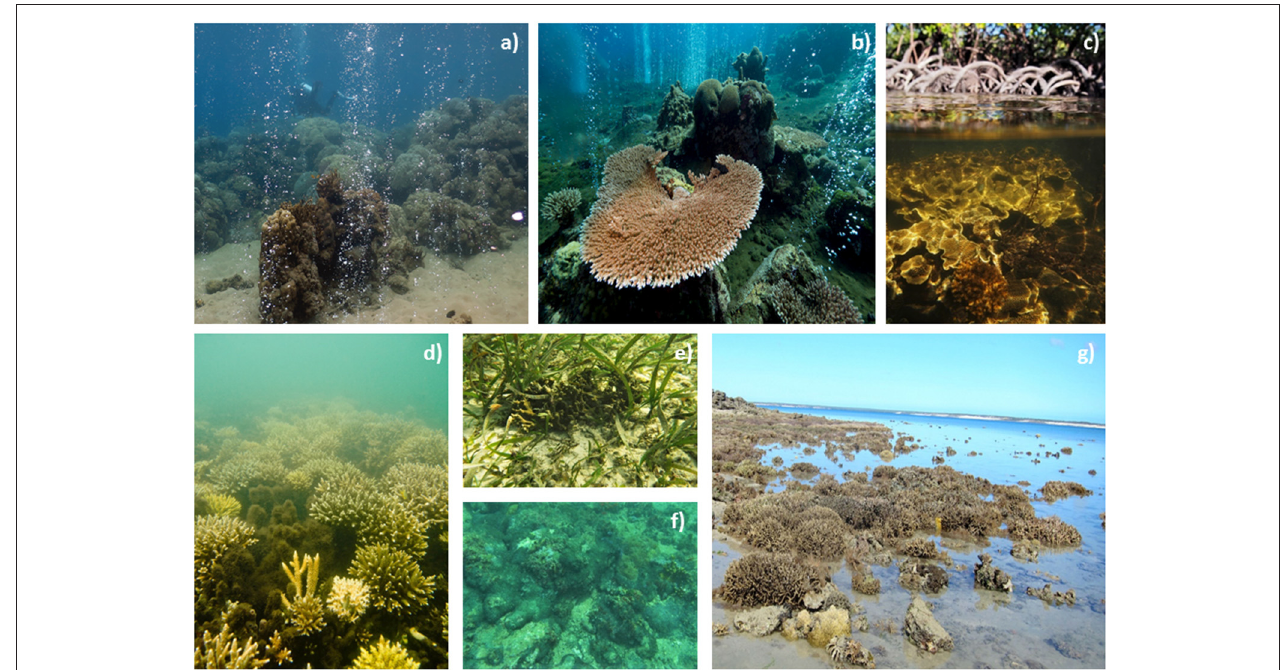
FIGURE 2 | Photographs from different extreme and marginal coral environments. (a,b) Vent sites in Papua New Guinea (photo credit R. Rodolfo-Metalpa and J.M. Boré), (c) mangrove system Great Barrier Reef (photo credit E. Camp), (d) mangrove system New Caledonia (photo credit E. Camp), (e) seagrass bed the Cayman Islands (photo credit E. Camp), (f) turbid reef Salvador Brazil (photo credit E. Camp), (g) Kimberley reef flat (photo credit V. Schoepf).